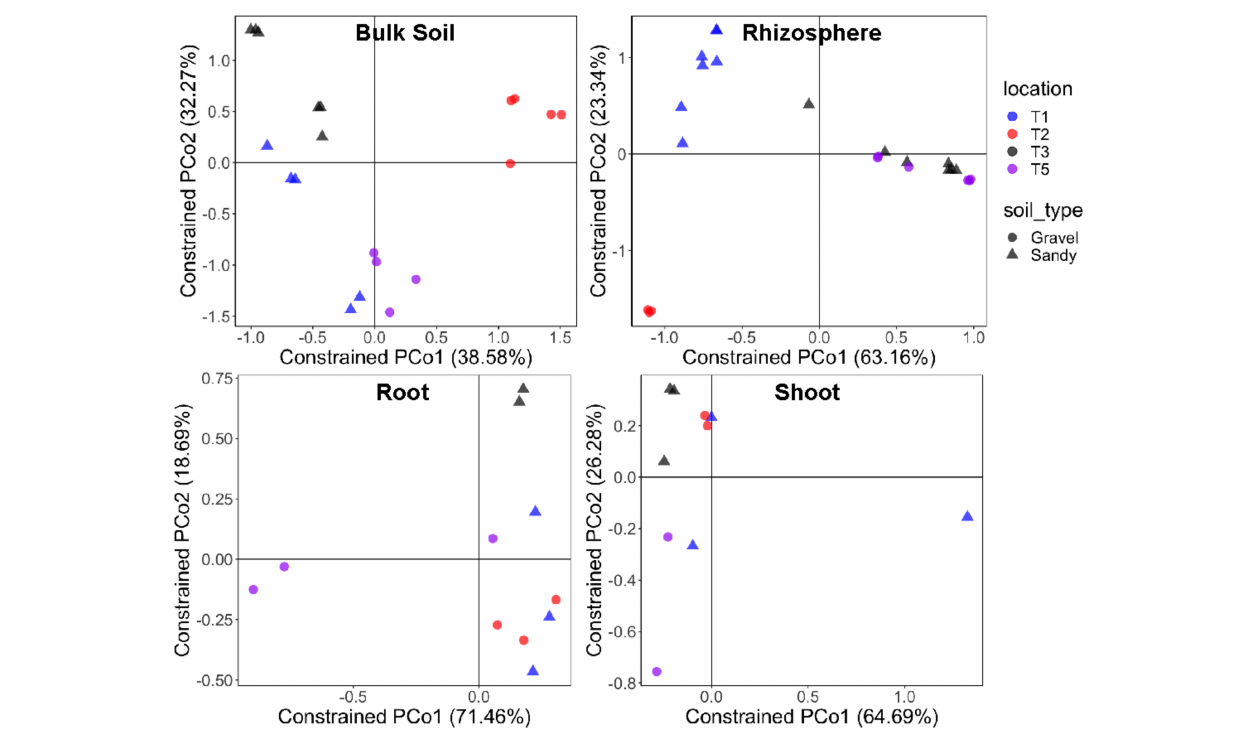
FIGURE 3 | Bacterial community structure in each specific sampling compartment. Constrained analysis of principal coordinates (CAP) based on the Bray-Curtis distance matrix of the 16S rRNA gene ASV table, showing the ordination of samples according to the factors sampling location and soil type in each compartment separately. The percentage of variation explained by the two first axes is provided for each graph. Different colors stand for the four locations, while different symbols stand for the two soil